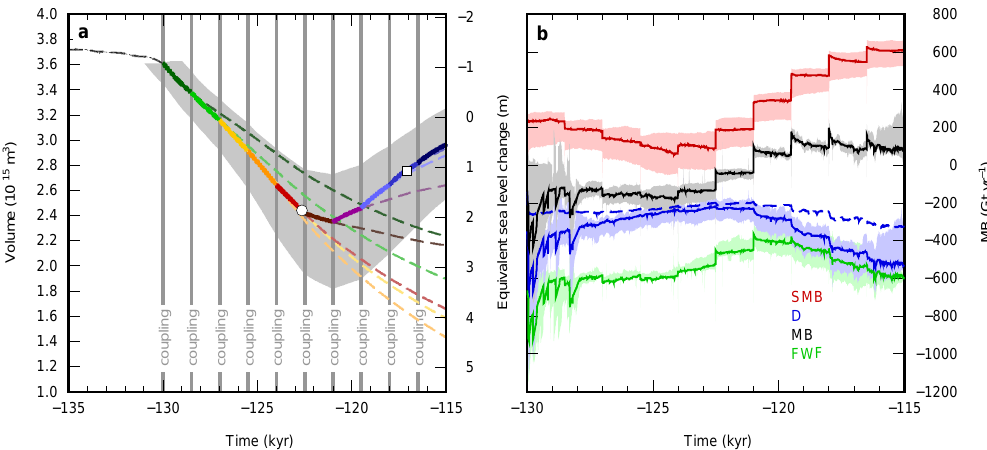
Time (kyr) Fig. 5. Eemian ice volume changes and mass balance components. (a) Simulated GrIS volume change and equivalent sea level contribution. The colours indicate different climate forcings. Dashed lines show ice volume evolution without additional coupling. Circle (square) indicates the timing of ice margin retreat (re-advance) at Dye-3. (b) Time series of SMB (red), D (blue), MB (black) and FWF (green). D and FWF are shown as negative numbers to express mass loss. The blue dashed line represents the calving flux along the southeastern margin, south of 68 ◦ N (see text). Background shading represents the uncertainty